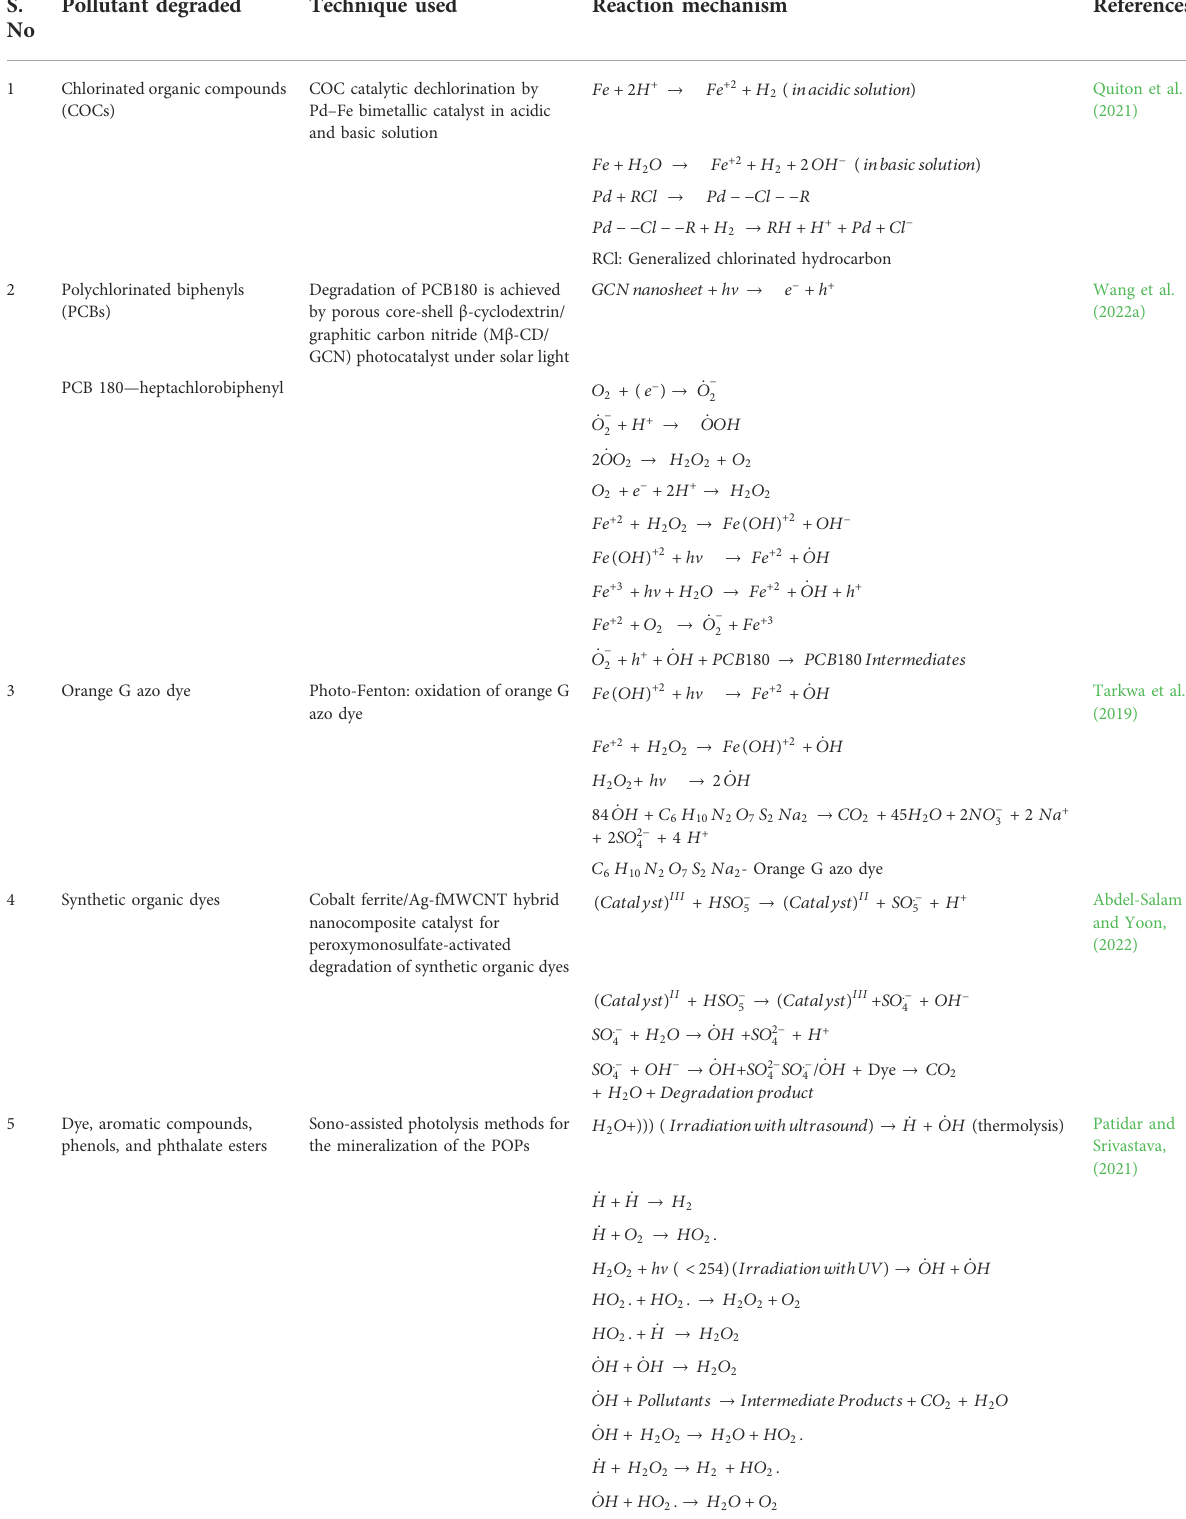
TABLE 4 Some of the reaction mechanisms for the degradation of persistent organic pollutants using advanced oxidation technologies, such as photocatalysis. S.